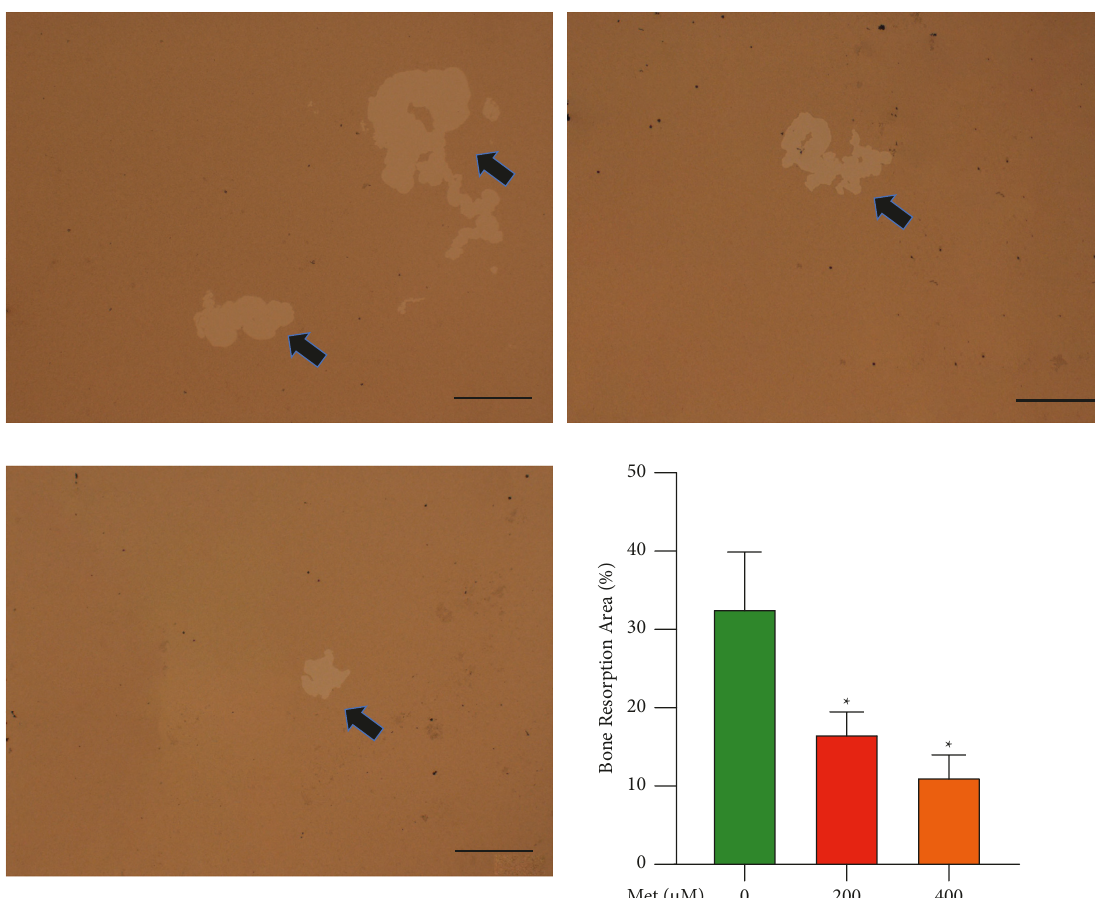
Figure 2: Met impaired bone resorption capacity of osteoclasts, BMMs were induced and cultured in medium with the addition of M-CSF (50ng/mL), RANKL (100ng/mL), and 0, 200, or 400 μ M Met for 5d, and representative images of bone resorption area (%) were observed and photographed using a microscope (scar bar � 100 μ m, ∗ p < 0 . 05). The black arrows indicate the bone resorption